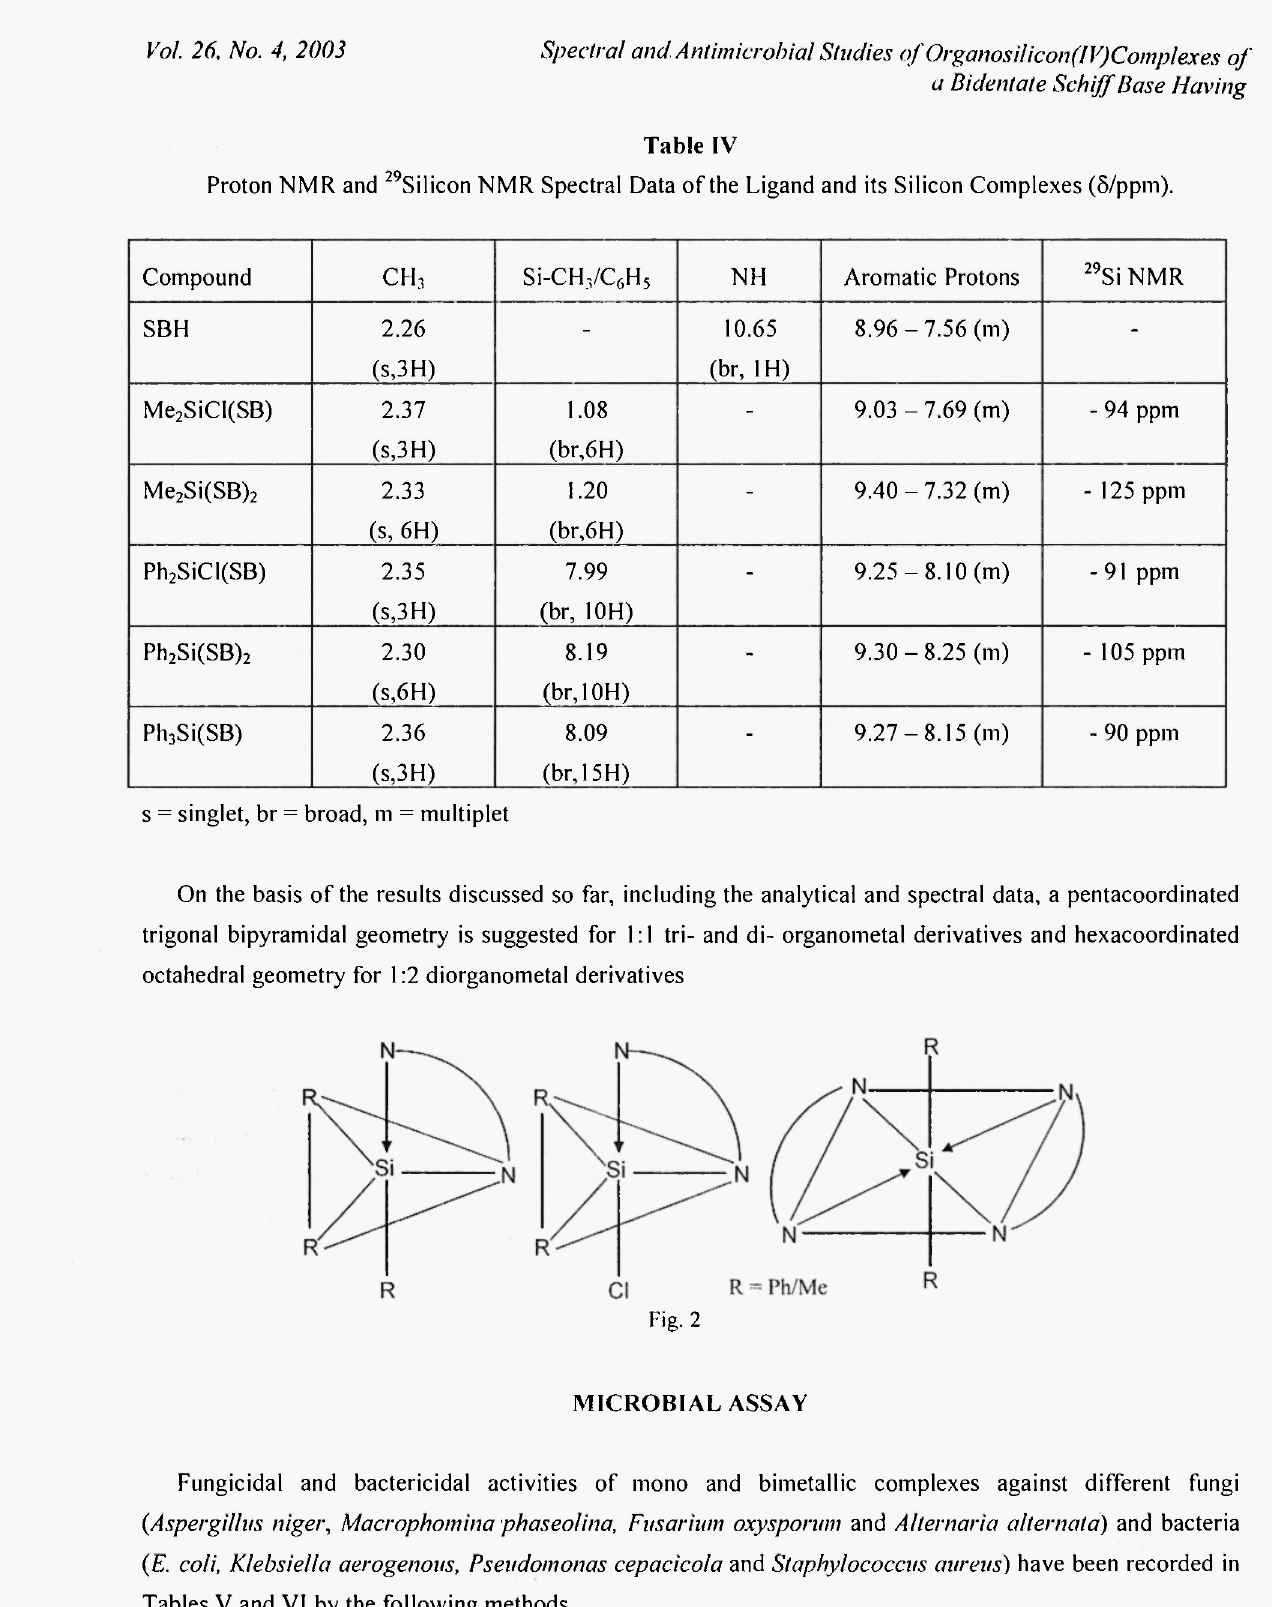
Proton NMR and 29 Silicon NMR Spectral Data of the Ligand and its Silicon Complexes